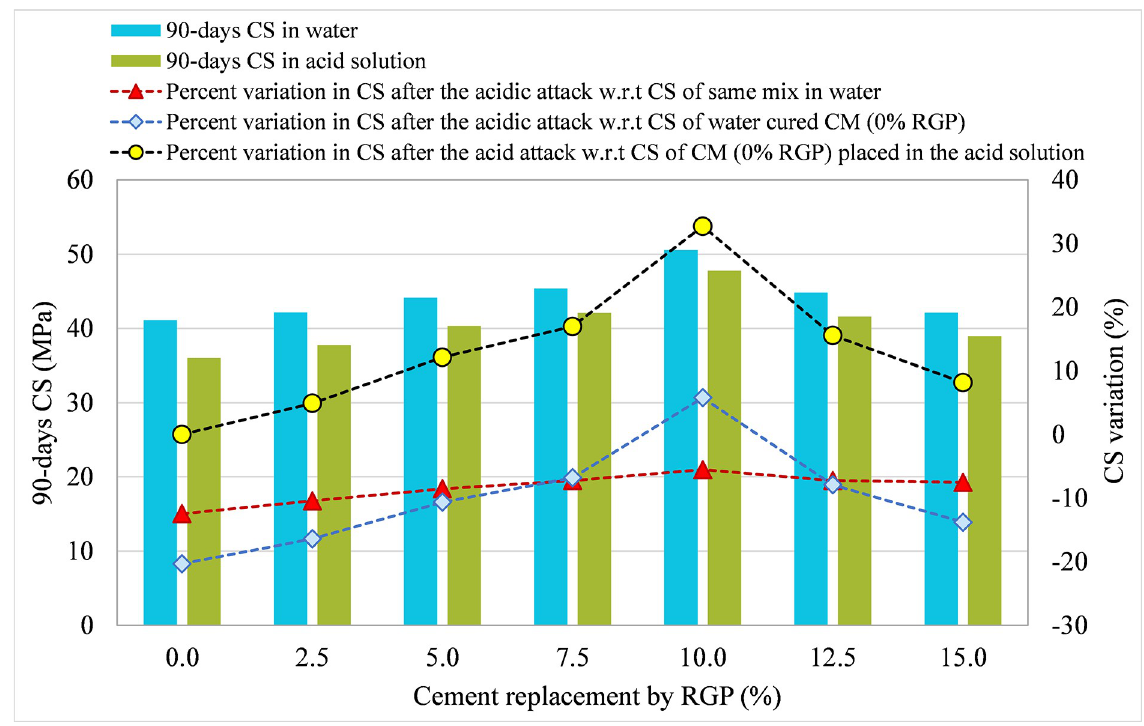
Fig 12. CS variation in samples placed in plain water and the acid solution for SF-25 mix incorporating RGP as a cement replacement.